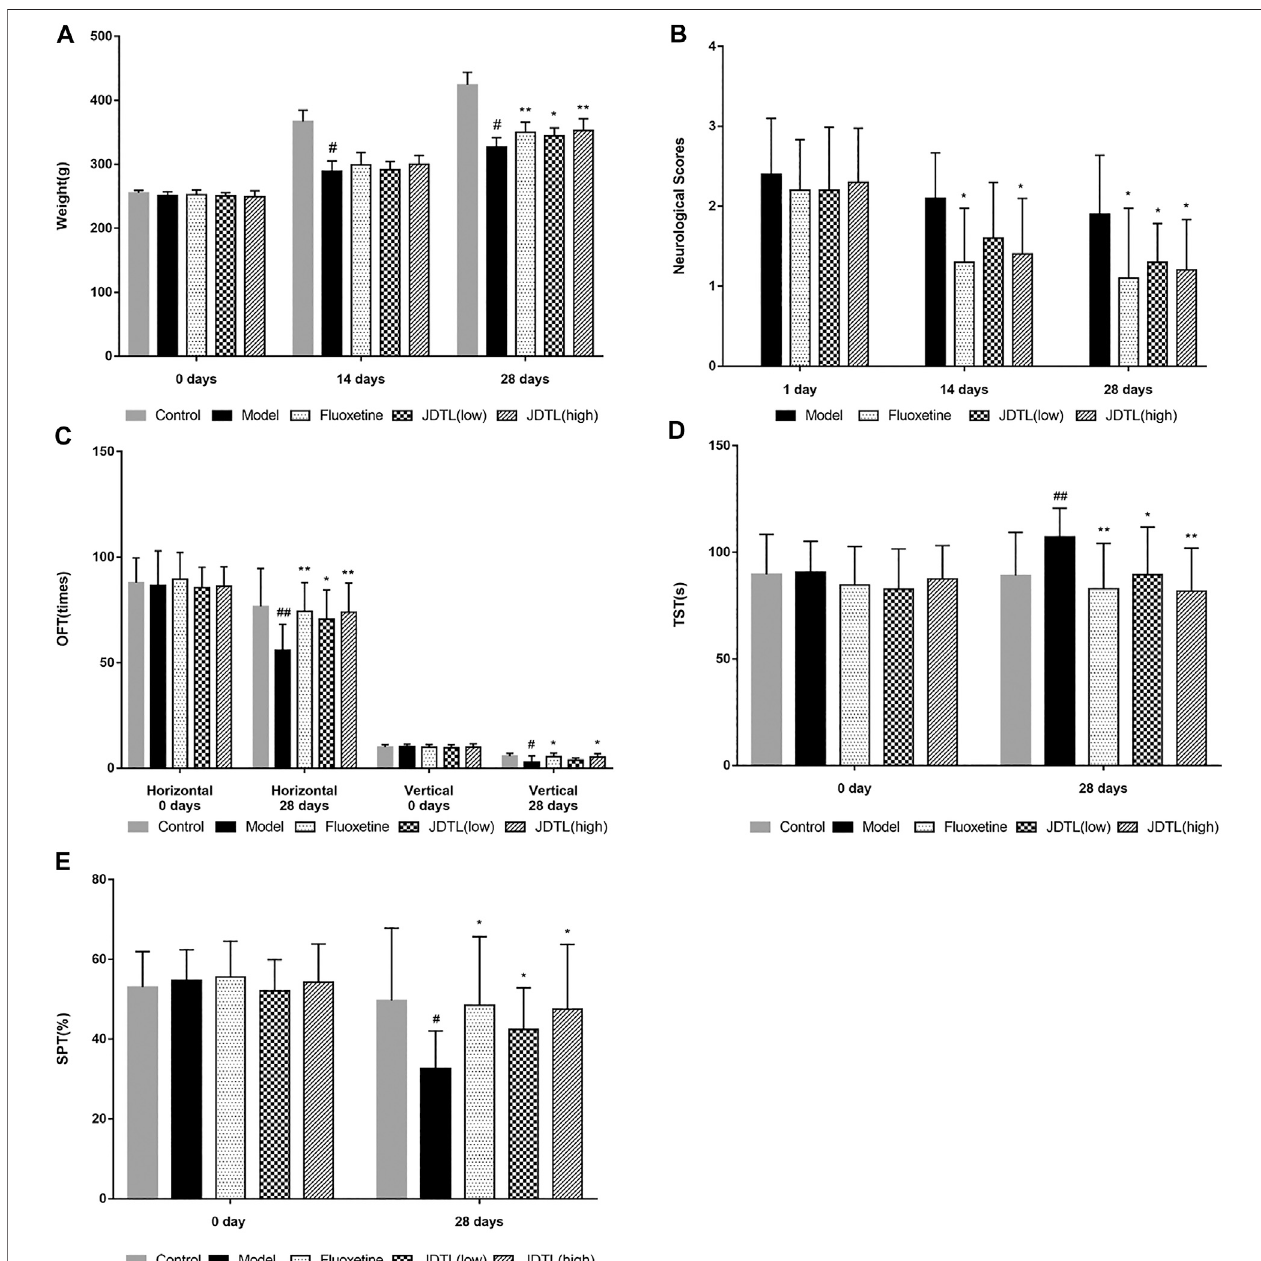
FIGURE 3 | JDTL Granules Ameliorated PSD-Induced Neurological De fi cits and Depressive Symptoms. (A) Bodyweight. (B) Neurological de fi cit scores. (C – E) Neurobehaviorals (C) OFT, (D) TST, (E) SPT. All data were expressed as mean ± SD, n (cid:2) 10. ## p < 0.01, # p < 0.05 vs. Control group, ** p < 0.01, * p < 0.05 vs. Model